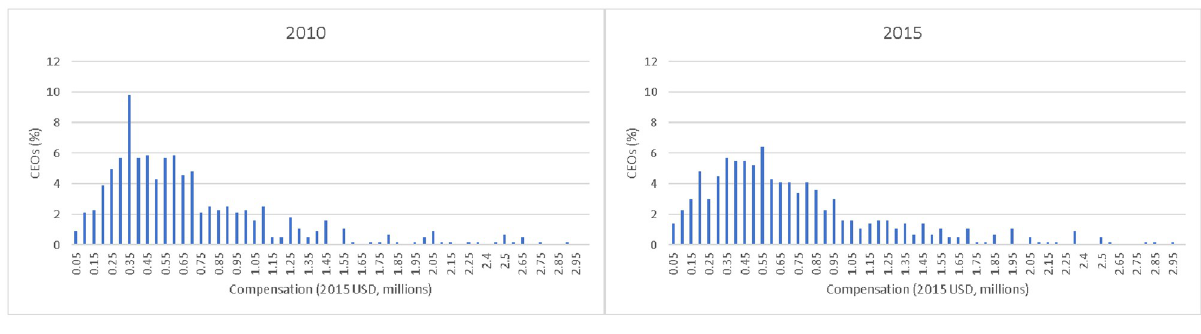
Fig 1. CEO compensation by